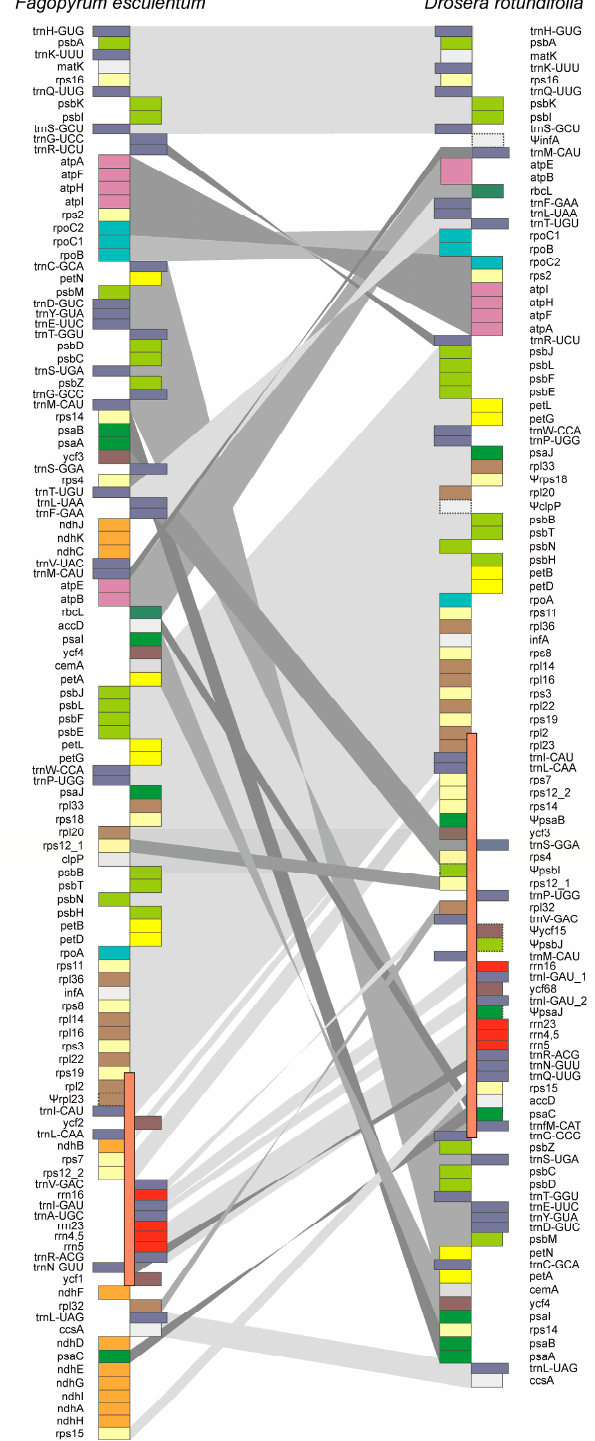
Figure 1. Schematic gene order comparison map between the plastid genomes of D. rotundifolia and F. esculentum . The linear representation of the circular mapping genomes using trnH-GUG genes as the starting point does not reflect the actual gene size or spacing between the coding regions. The inverted repeat is indicated by an orange rectangle on the main line; only one copy is shown. Boxes represent protein-encoding and RNA genes; genes transcribed in opposite directions are shown to the left and to the right of the main line. The gray areas between the genes highlight the relative locations of identical genes. Ψ denotes pseudogenes.